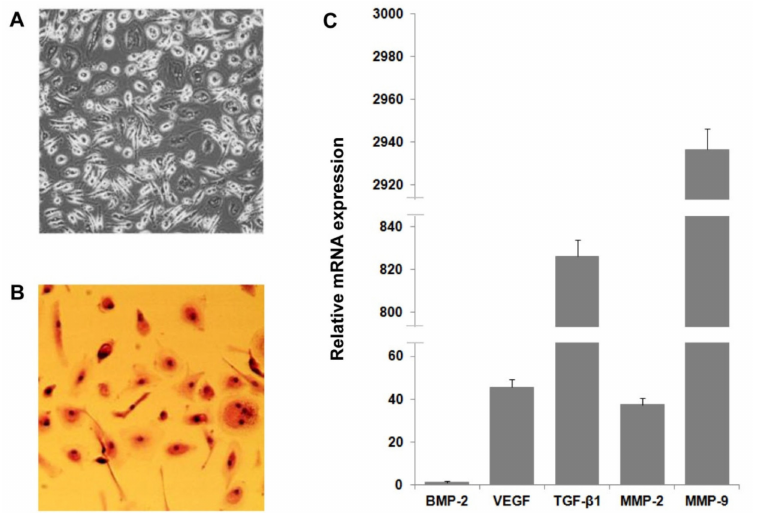
Figure 5. CGF-derived cell characterization and expression of pro-angiogenic factors. Cells were released by CGF clot and cultured in M199 medium ( A ). CGF cell morphological characterization was determined by hematoxylin–eosin staining ( B ). RNA was extracted from CGF-derived cells, and levels of pro-angiogenic factor expression were analyzed by qRT-PCR. GAPDH was considered a housekeeping gene. The expression level of genes is referred to with BMP-2 (=1) as the lesser expressed gene ( C ). Data are representative of three independent experiments.